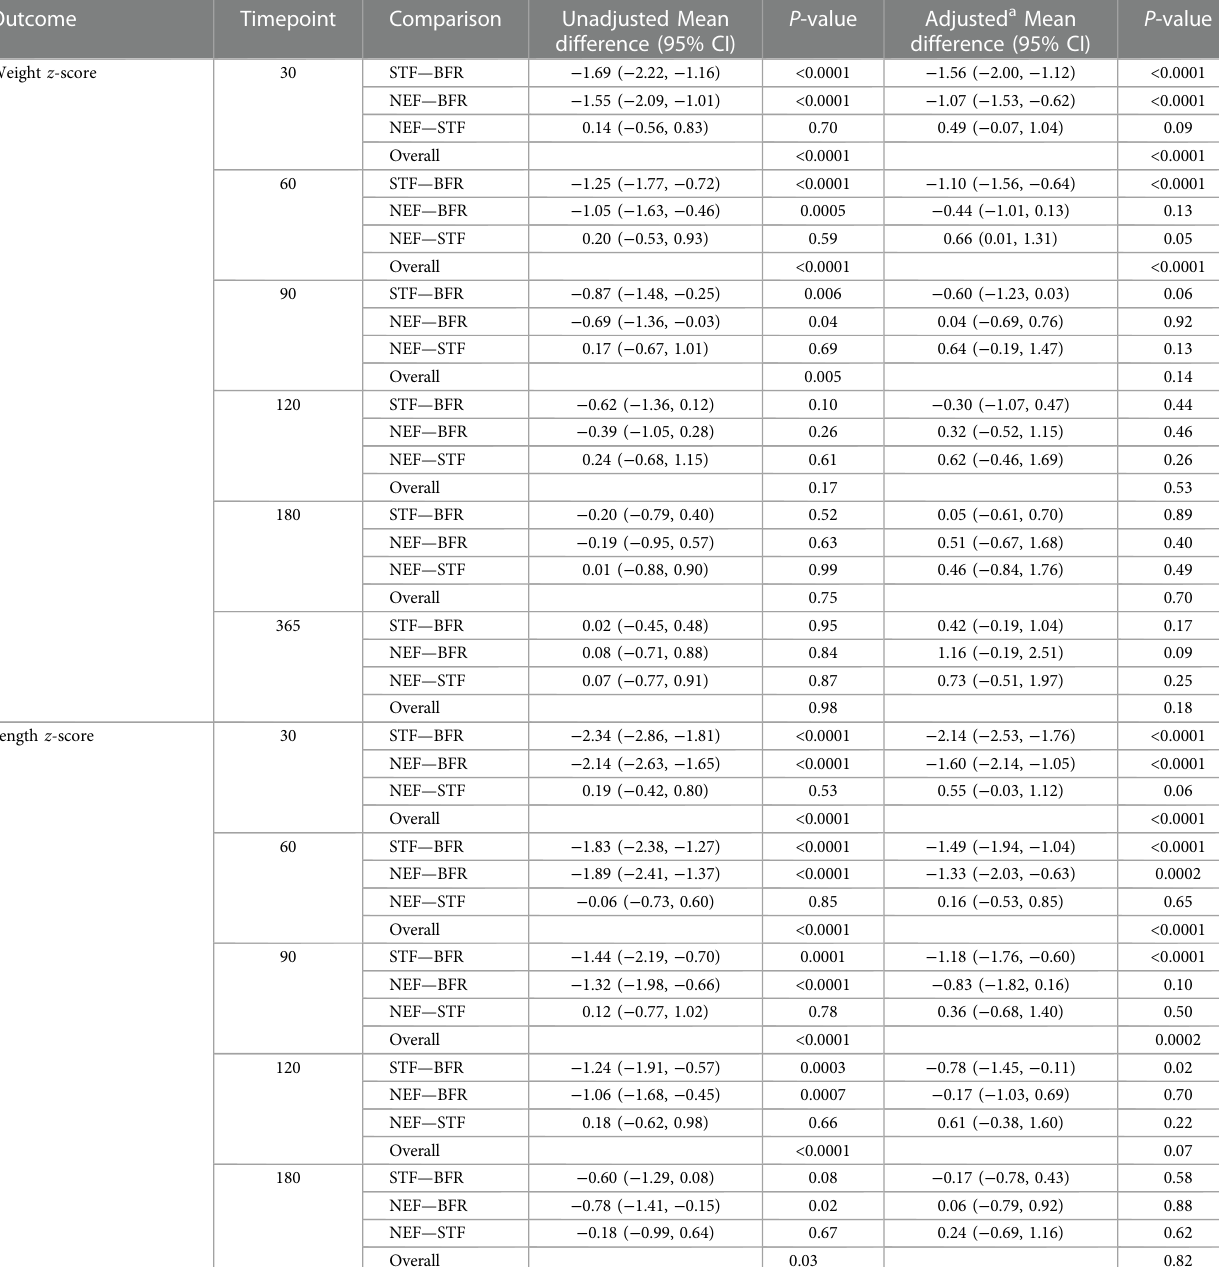
TABLE 5 Growth outcomes of randomized late preterm infants and term breastfeeding reference group.